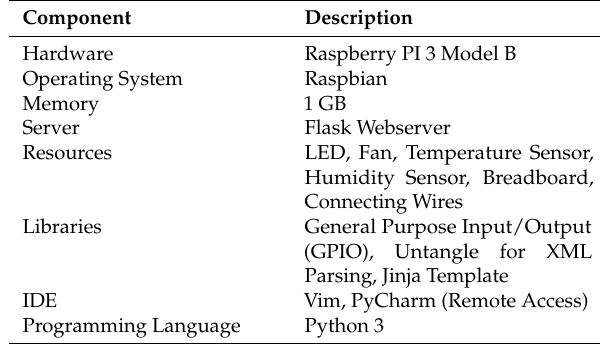
Table 1. Technology stack of the IoT server. IDE, Integrated Development Environment.